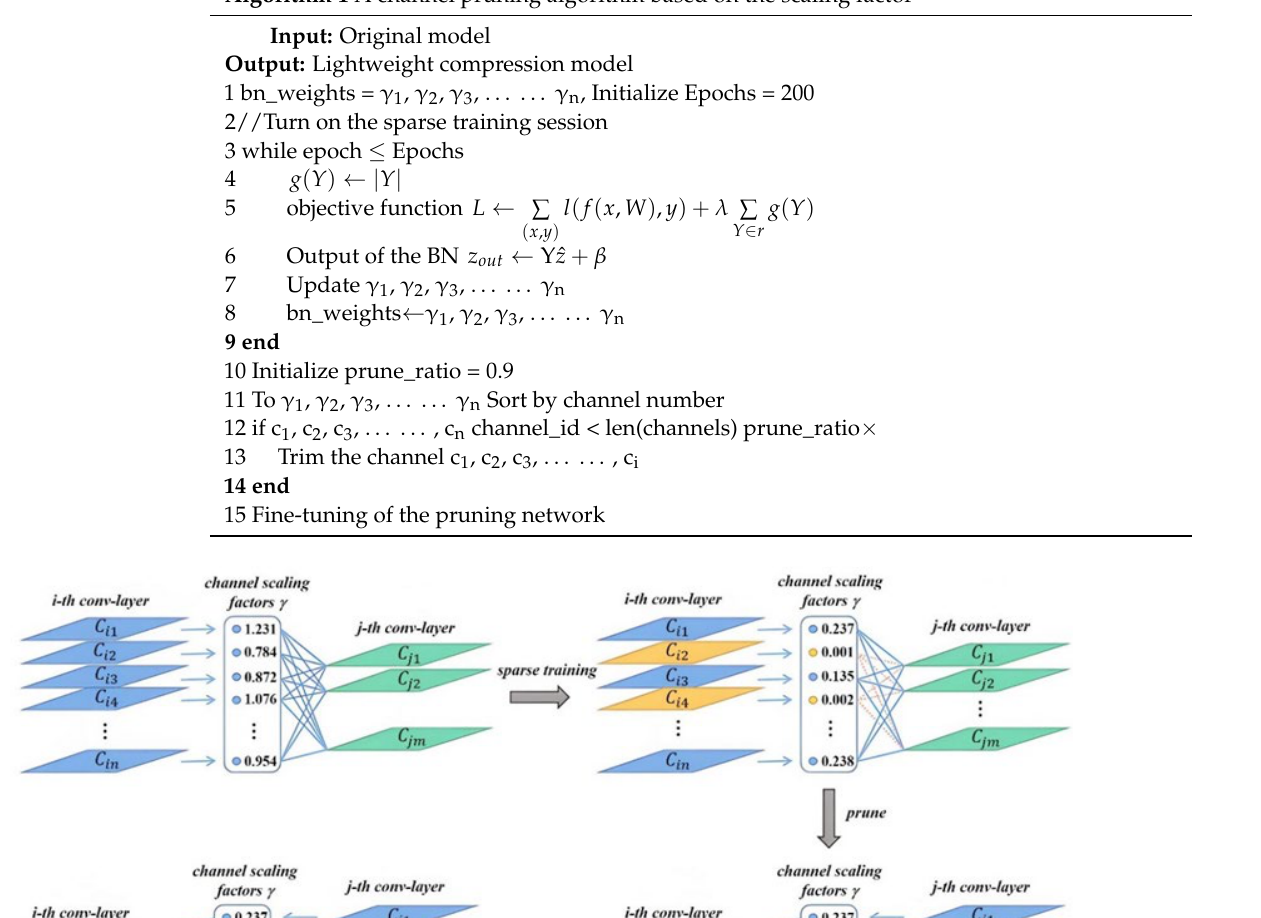
Figure 5. The flow of the channel pruning algorithm (The entire pruning process is divided into three steps: sparse training, pruning channel, and achieving accuracy recovery through fine-tuning).